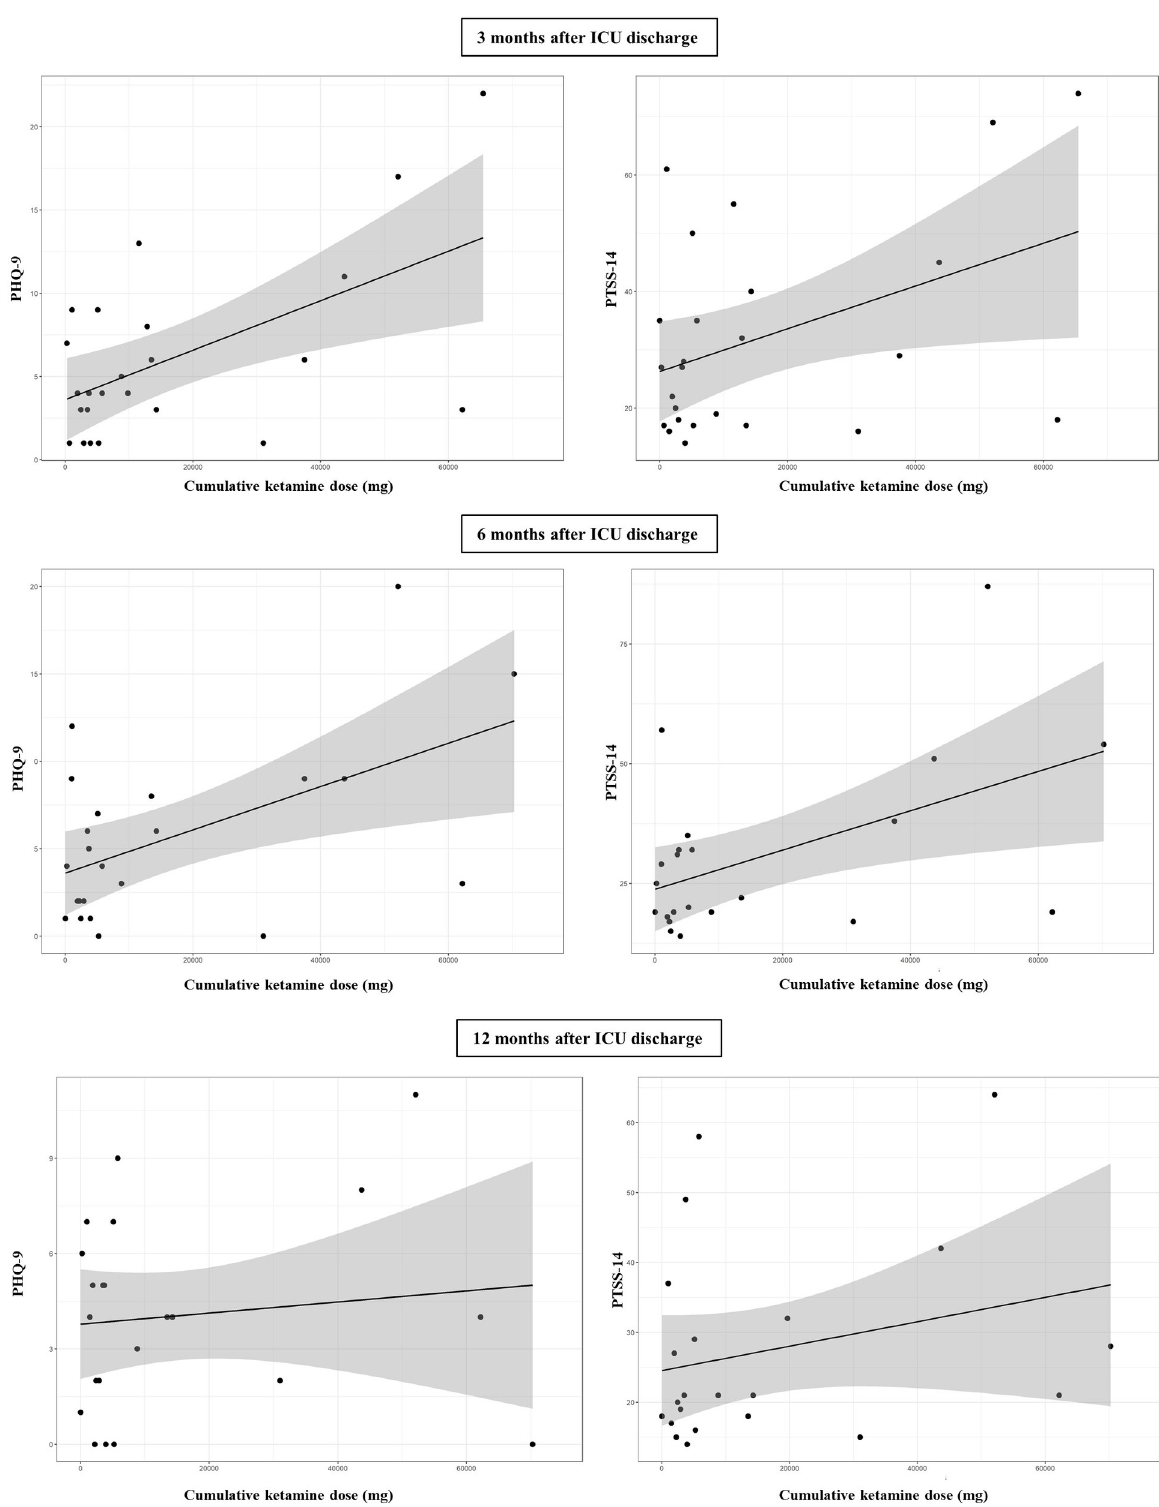
Fig 2. Relationship between cumulative dose of ketamine and psychiatric symptoms in ARDS survivors 3, 6 and 12 months after ICU discharge.